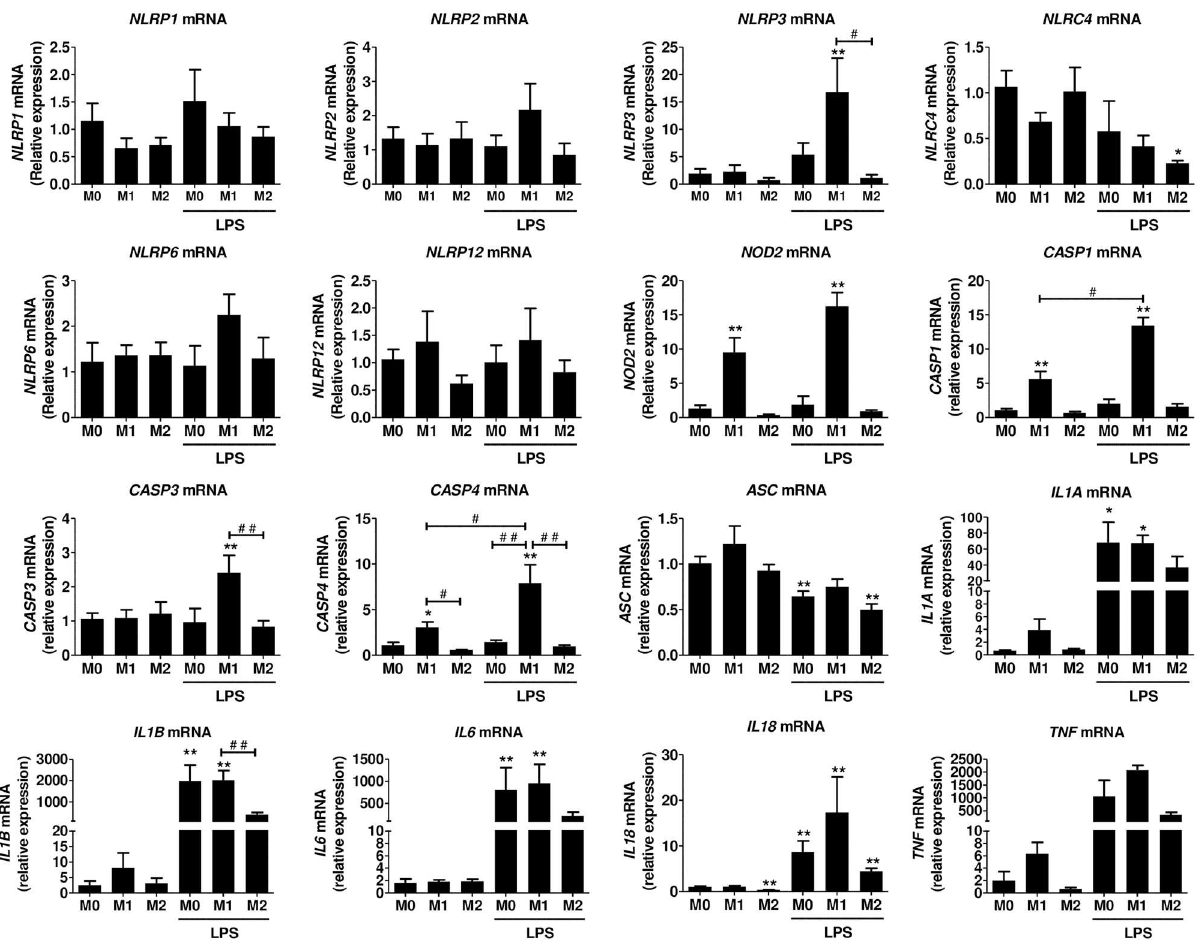
Fig 5. NLR, CASP and cytokine gene expression in human polarized macrophages. Monocyte derived macrophages were polarized towards M1, M2, or M0 and stimulated with 100 ng/ml LPS for 3h as describedin the methods. mRNA was isolated and geneexpression was measured by RT-qPCR and expressedas relativefold change of M0. Data represent the mean ± SEM of (cid:21) 4 experiments performed in duplicatesin cells isolatedfrom independentdonors. M0: cells treated with completemedium (control); M1: cells treated with 100 ng/ml IFN- γ (polarizedtowards M1); M2: cells treated with 10 ng/ml IL-4+IL-13 (polarizedtowards M2). Asterisks indicate significantdifferences as comparedto M0 (Mann Whitney test: * p < 0.05, ** p < 0.01); (#) points out significant differences betweenthe indicatedgroups (Mann Whitney test: # p < 0.05; ## p <